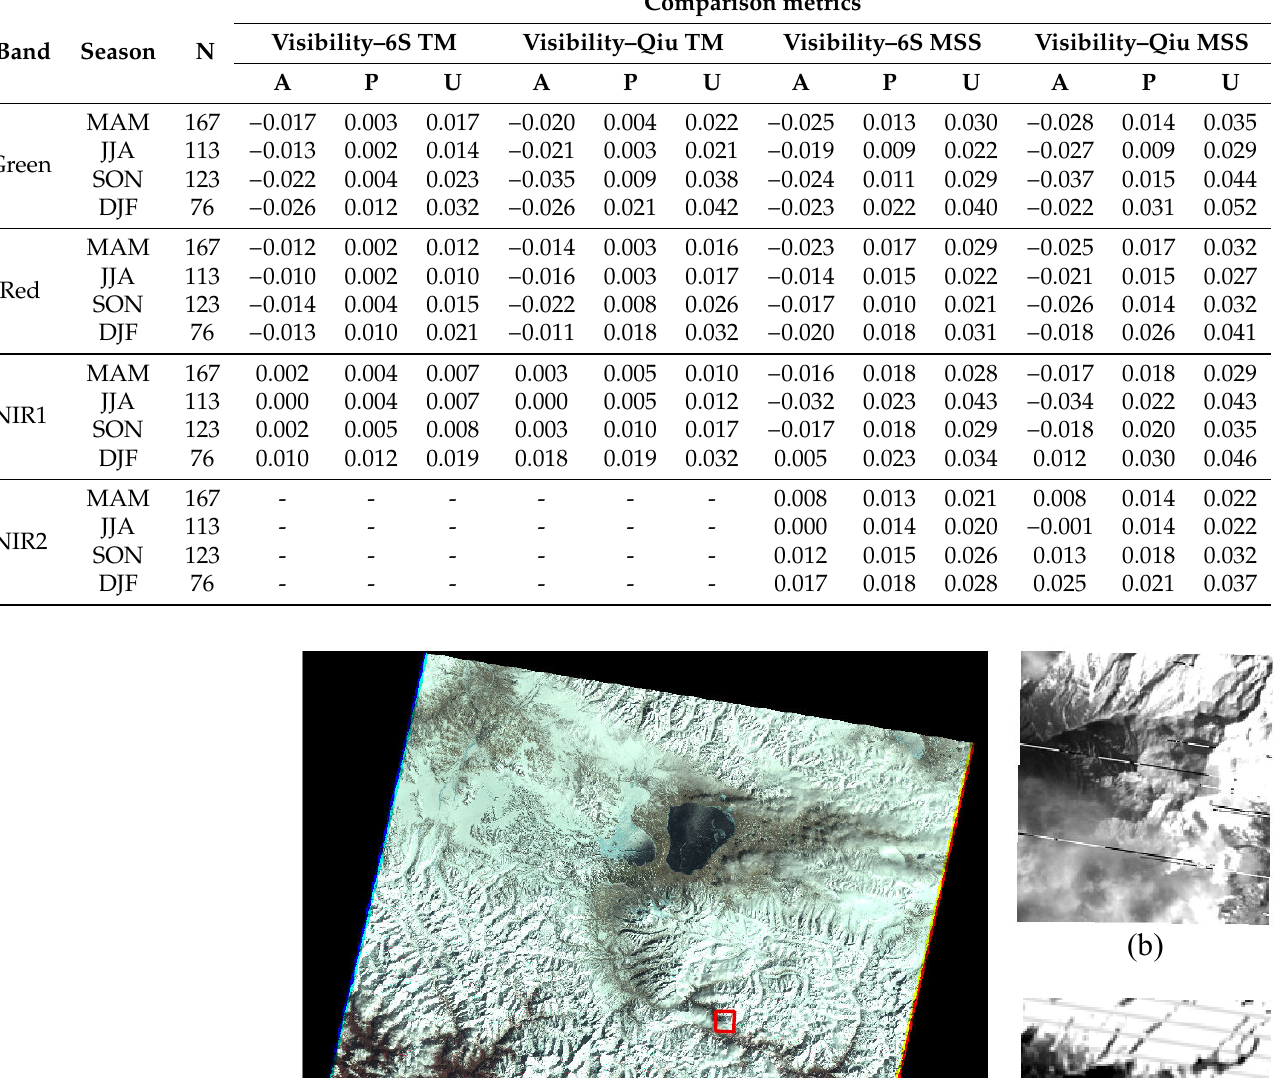
Table 6. APU scores by seasons of LSR by visibility–6S method and visibility–Qiu method (MAM: January, February).